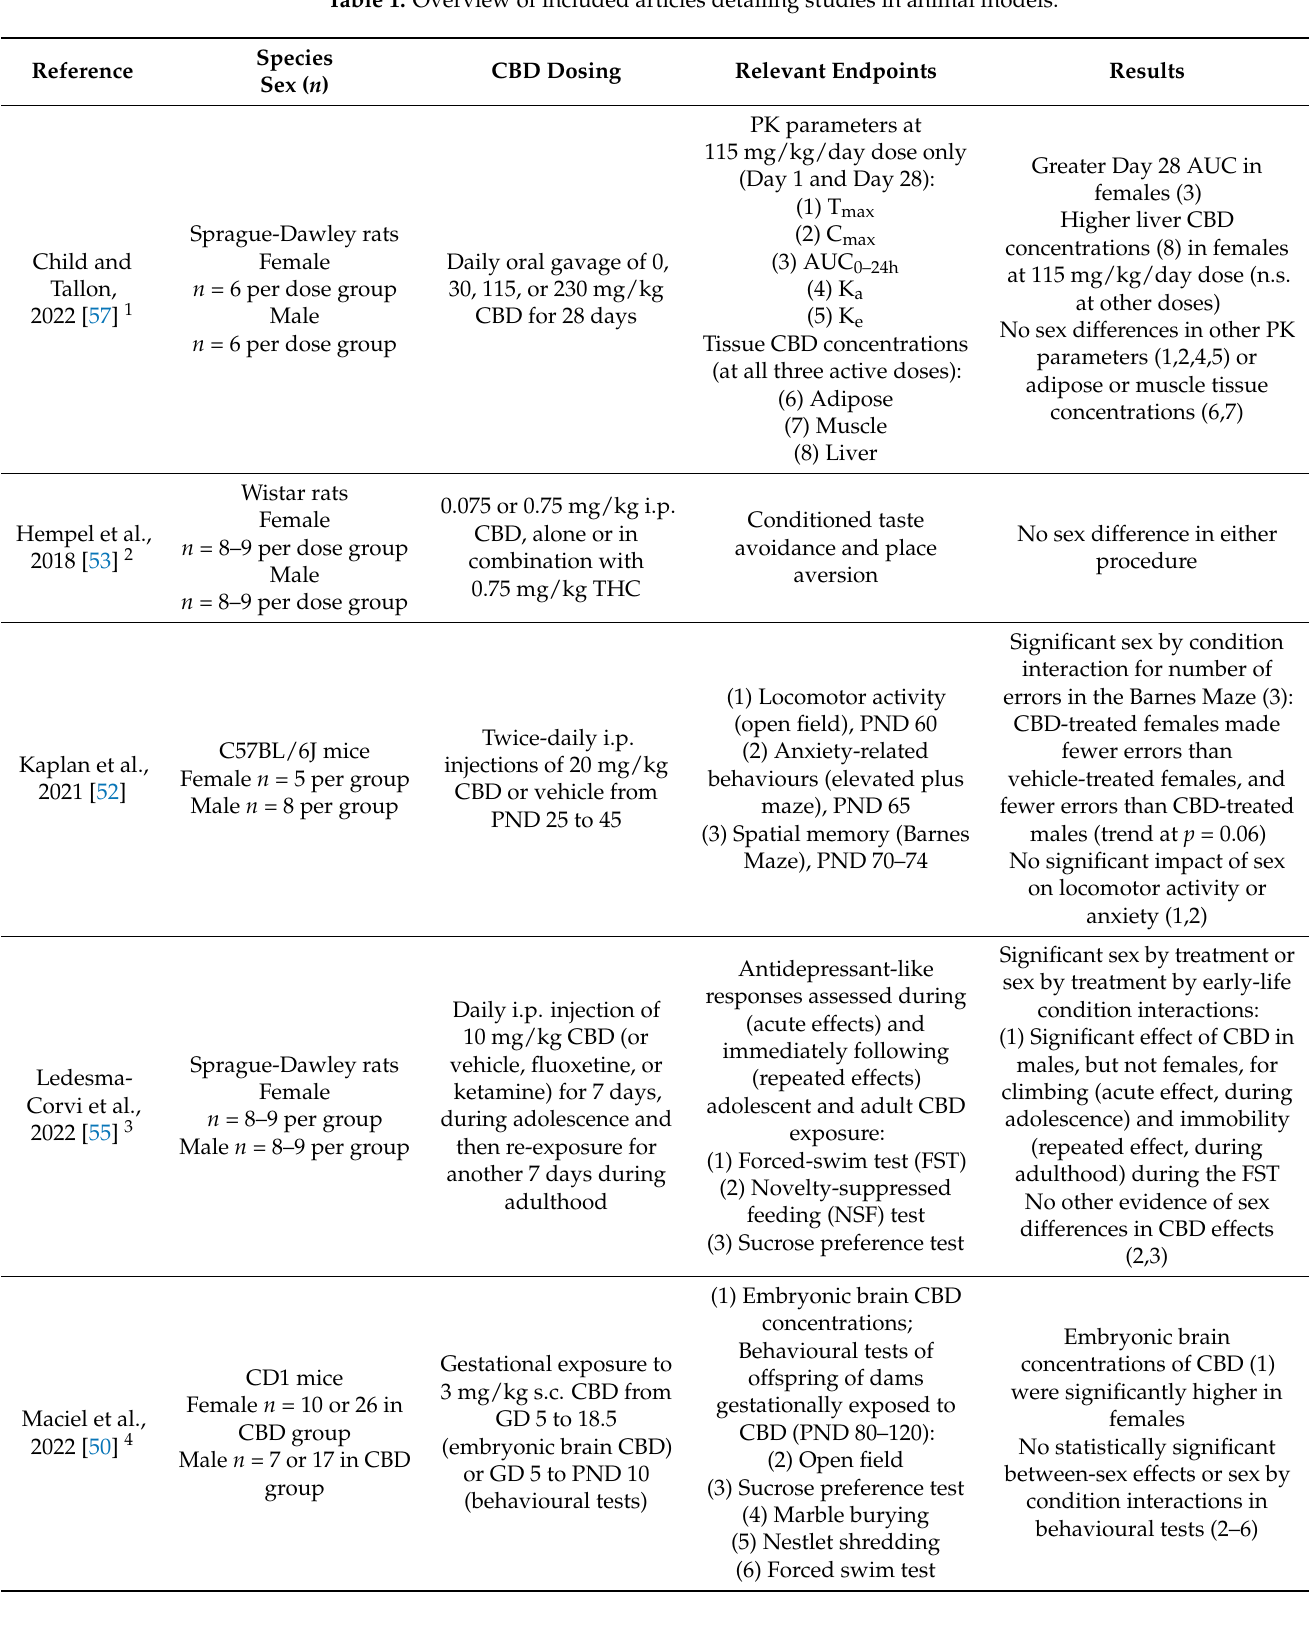
Table 1. Overview of included articles detailing studies in animal